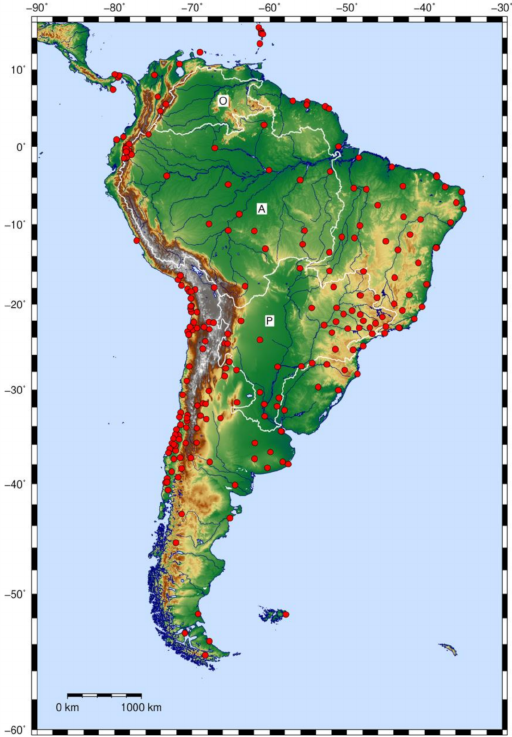
Figure 4. Map of the 247 continuous GPS stations selected in South America used in this study. The different river basin limits are shown with a white solid line: Amazon ( A ), Parana ( P ), and Orinoco ( O